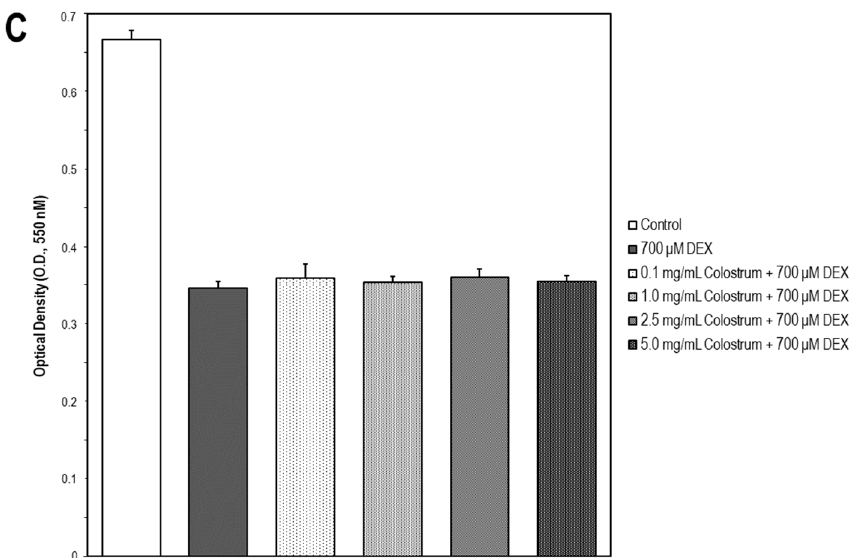
Figure 7. Colostrum rescues MC3T3-E1 cells from DEX cytotoxicity. MC3T3-E1 cells were treated with colostrum (0.1, 1.0, 2.5 and 5.0 mg/mL) for 1 h and then cell incubation continued with DEX (200, 400, or 700 μ M) for 24 h. Cell viability was measured by the MTT assay. The data are expressed as the mean ± S.E.M. of three independent experiments. ( A ) Significant increases were found in OD values elicited by 2.5 or 5 mg/mL colostrum + 200 μ M DEX compared with the 200 μ M DEX treated cells (Newman–Keuls test, * p < 0.01 vs. 200 μ M DEX cells). ( B ) Significant differences in OD values were observed in 2.5 mg/mL colostrum + 400 μ M DEX compared to the 400 μ M DEX treated cells (Newman–Keuls test, * p < 0.05 vs. 400 μ M DEX cells). ( C ) No significant differences were found in OD values displayed by any colostrum concentration + 700 μ M DEX compared to the 700 μ M DEX treated cells.